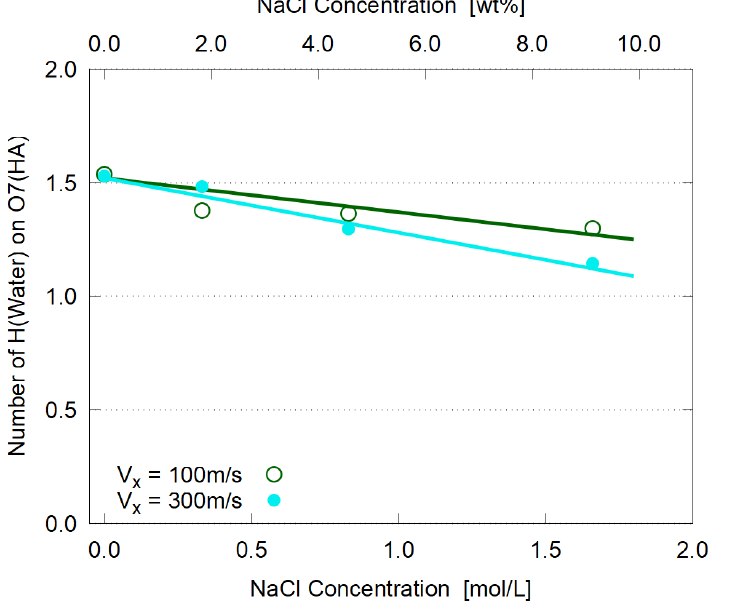
Figure 15. Coordination number, or the number of bound water molecules, on each O7 site of HA molecules; the lines are guides to the